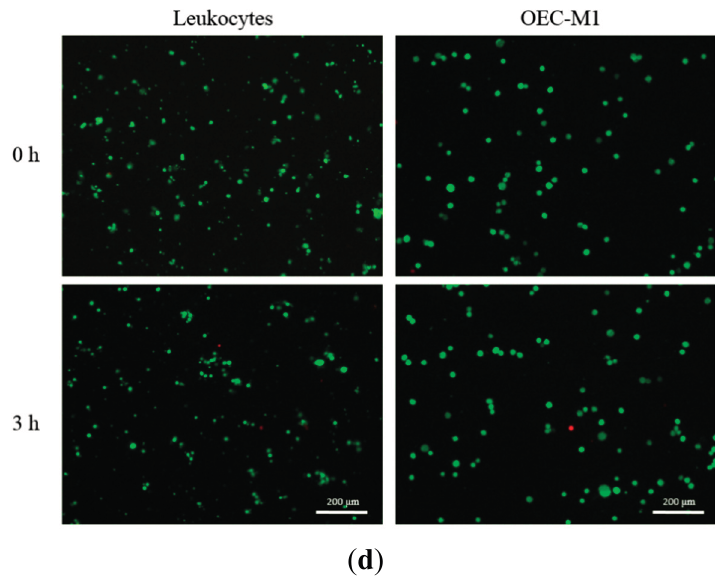
Figure 2. ( a ) The quantitative relationship between the flow rates of oil and cell suspension, and the resultant size (diameter) of micro-droplets; ( b ) Microscopic images of micro-droplets generated under three different operating conditions (oil flow rate: all 750 µL·h − 1 ; cell suspension flow rate: (I) 60, (II) 100, and (III) 140 µL·h − 1 ); ( c ) The size distribution of the micro-droplets (Oil flow rate: 750 µL·h − 1 , Cell suspension flow rate: 110 µL·h − 1 ; Inset image: microscopic images of micro-droplet); ( d ) Microscopic observation of cell viability after micro-droplet-based microencapsulation process, and after 3 h static incubation using the Live/Dead ® fluorescent dye. Green and red dots represent live and dead cells, respectively. The left and right images show the leukocytes, and OEC-M1 cells,